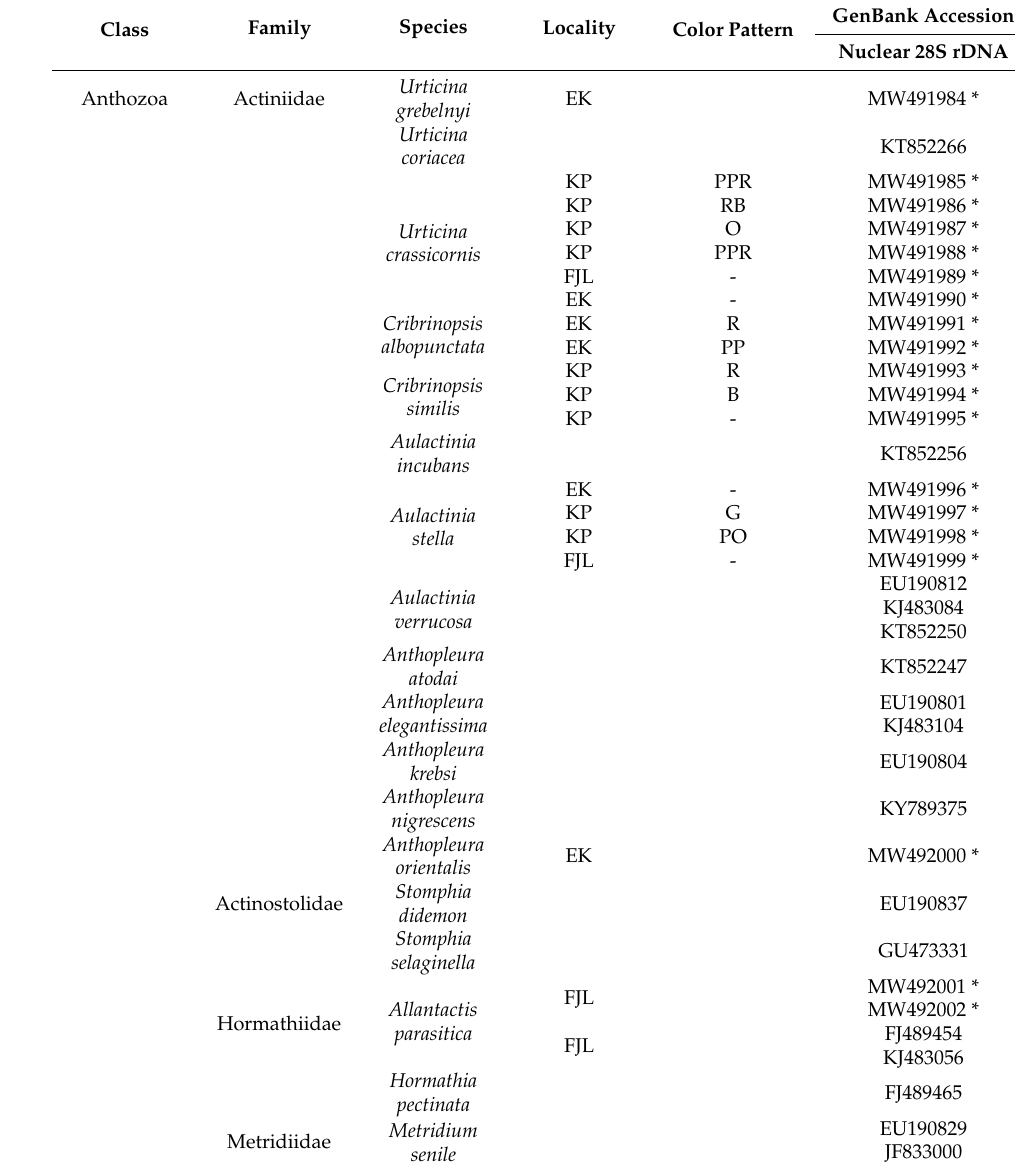
Table 2. Species analyzed phylogenetically based on the partial sequences of nuclear 28S rDNA gene. The collection site of species reported in this study (KP—Kola Peninsula, FJL—Franz Josef Land, EK—East Kamchatka) and color pattern for specimens of species that varied in their coloration: Urticina crassicornis , Cribrinopsis similis , C. albopunctata , and Aulactinia stella , are given (PPR—pale pink with red stripes, PP—pale pink, RB—red–blue blotched, PO—pale orange, OG—orange with gray tentacles, O—orange, R—red, G—gray, B—beige). * sequences reported in this study (Clustal X), - no data. Class Family